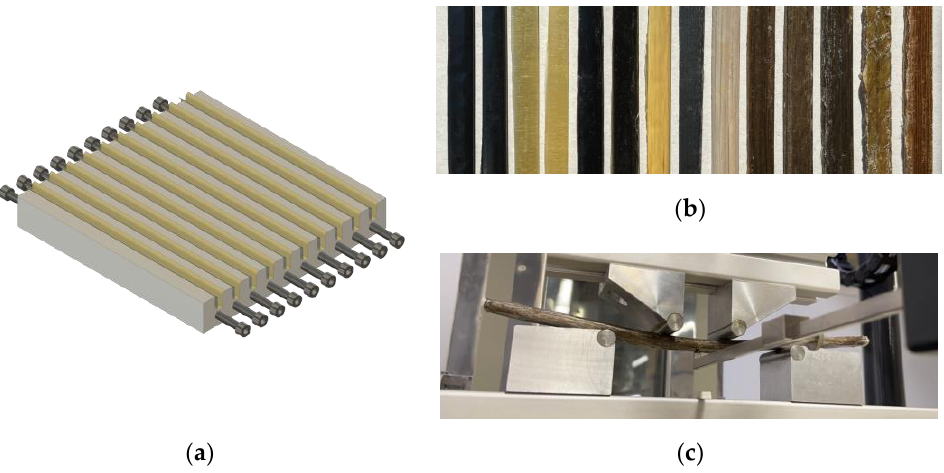
Figure 6. Four-point bending sample production and testing. ( a ) Aluminum mold for the sample production; ( b ) one produced sample of each material combination; ( c ) four-point bending test of flax sample.